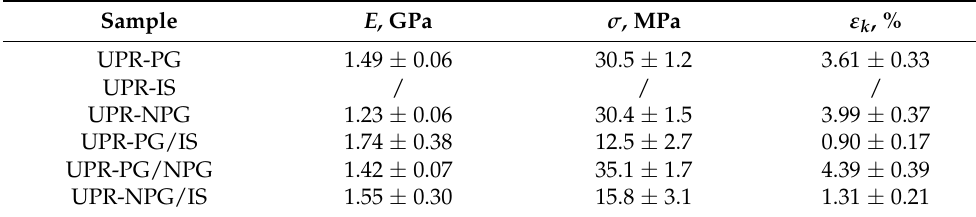
Table 3. Tensile properties of the prepared